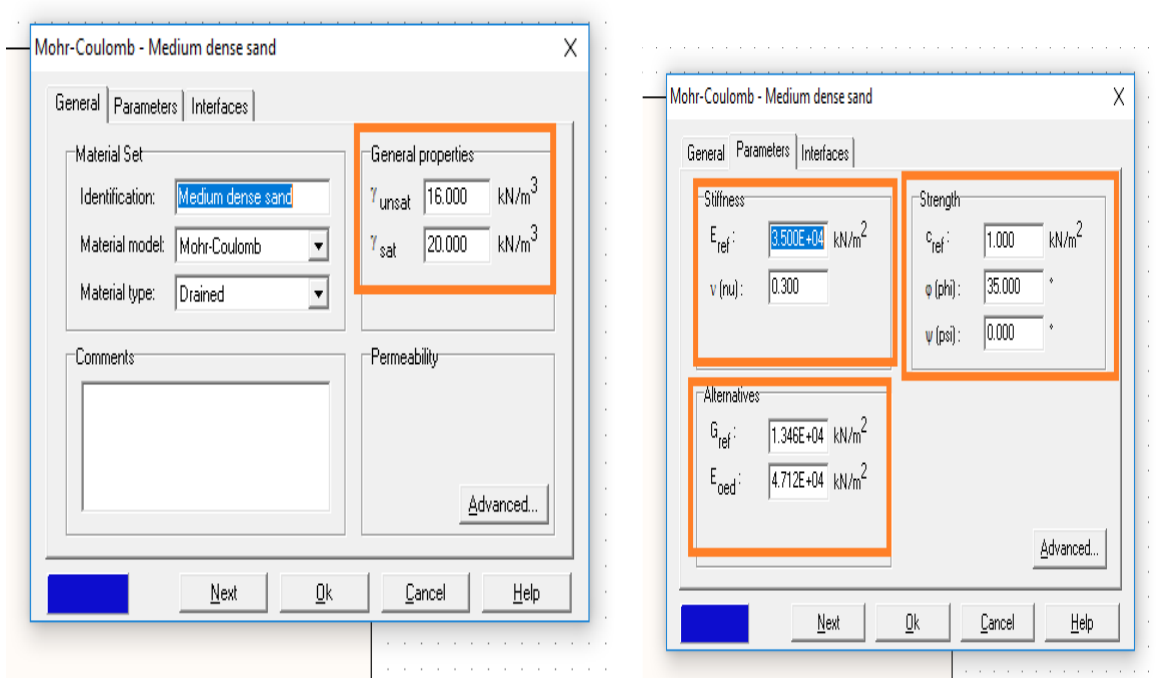
Fig. 6. Soil layer data a) General inputs of soil, b) Parameters input of